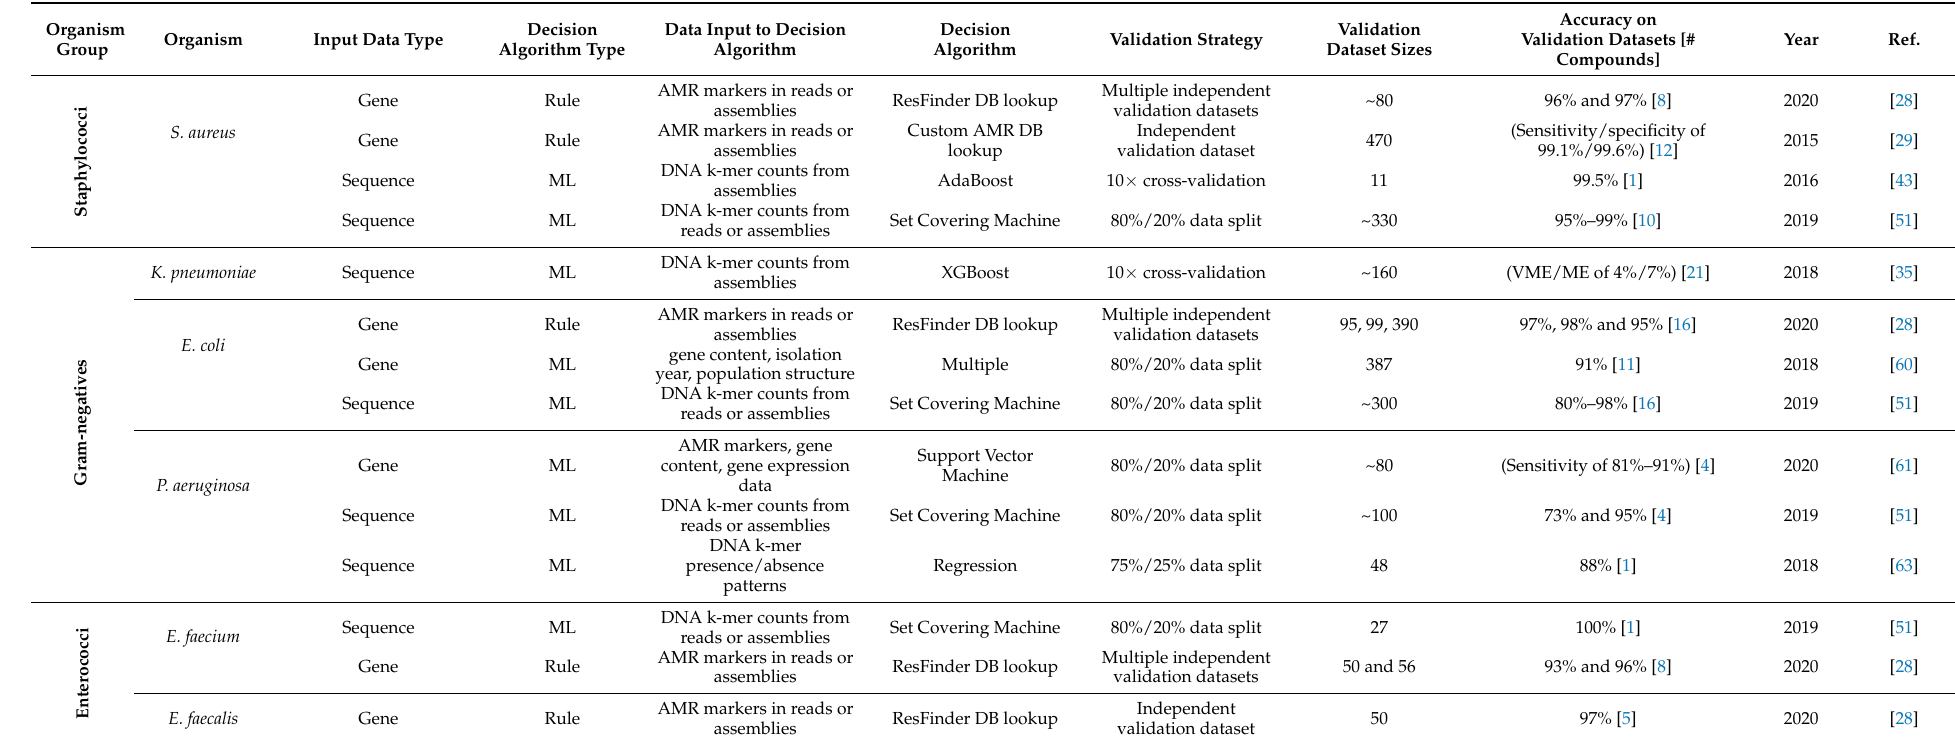
Table 1. Selected pAST methods targeting organisms relevant to